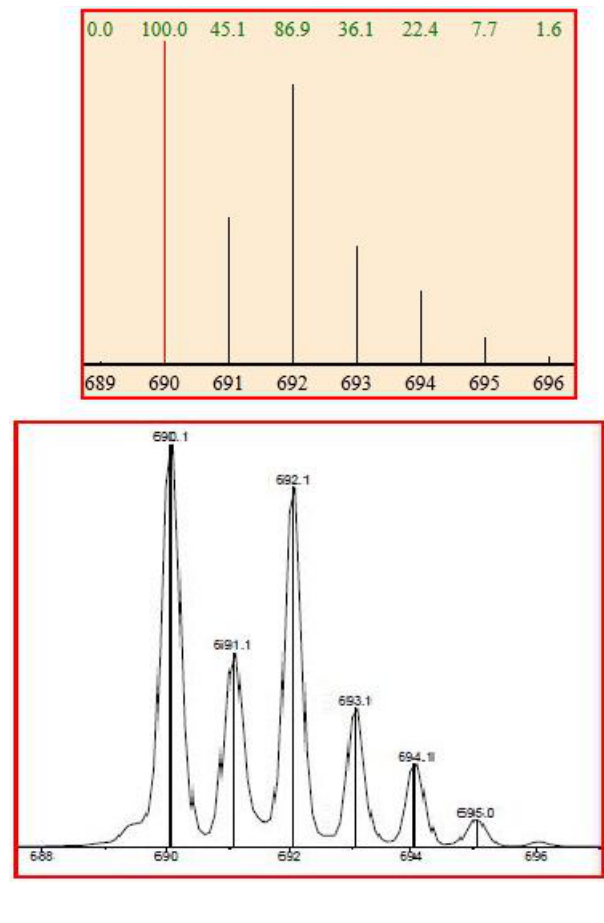
Figure 10. Comparison between calculated (upper) and experimental ESI-MS spectra for 15